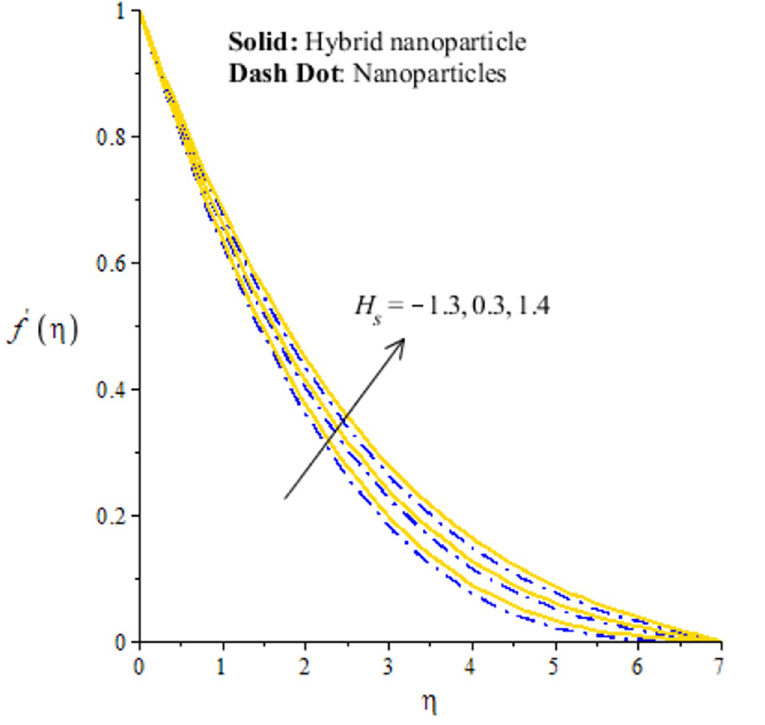
Fig 6. Distribution of velocity versus H s .